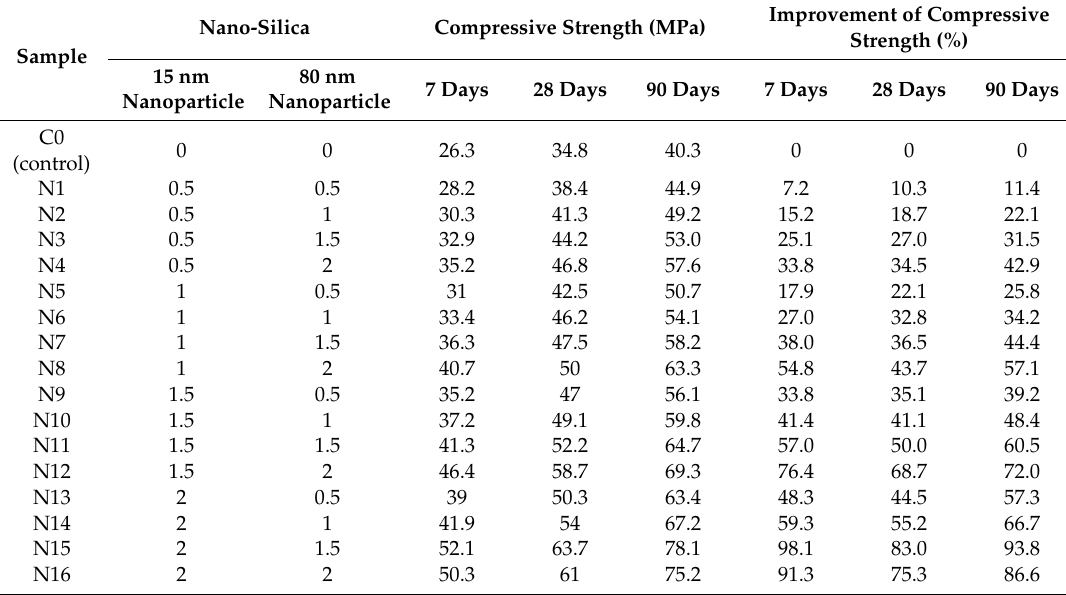
Table 1. Compressive strength of concrete specimens containing several nano-silica contents. Reprinted with permission from [86]. Copyright © 2019, Elsevier